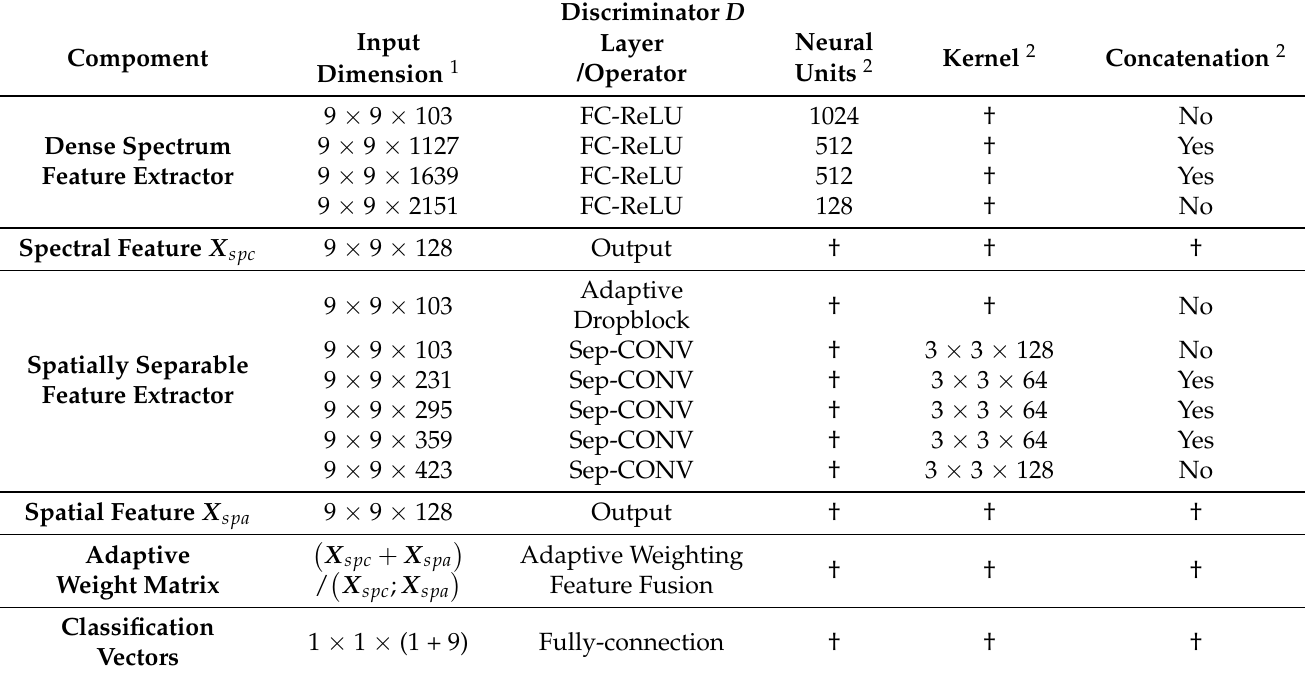
Table 2. Specific configurations of the proposed discriminator D of the AWF 2